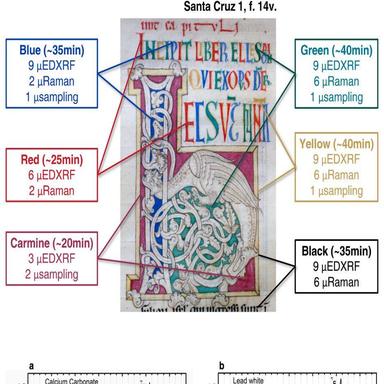
The pink colour used in this Romanesque initial was made admixing vermilion with lac dye in a proteinaceous binding medium. The acquisition of the data necessary for a complete characterization of the formulation took 3h. Vermilion was identified through Raman microscopy by its characteristic bands at 252 cm− 1 and 282 cm− 1 . Infrared spectroscopy clearly shows the proteinaceous binder fingerprint. Microspectrofluorimetry and surface-enhanced Raman spectroscopy identified lac dye by compariso